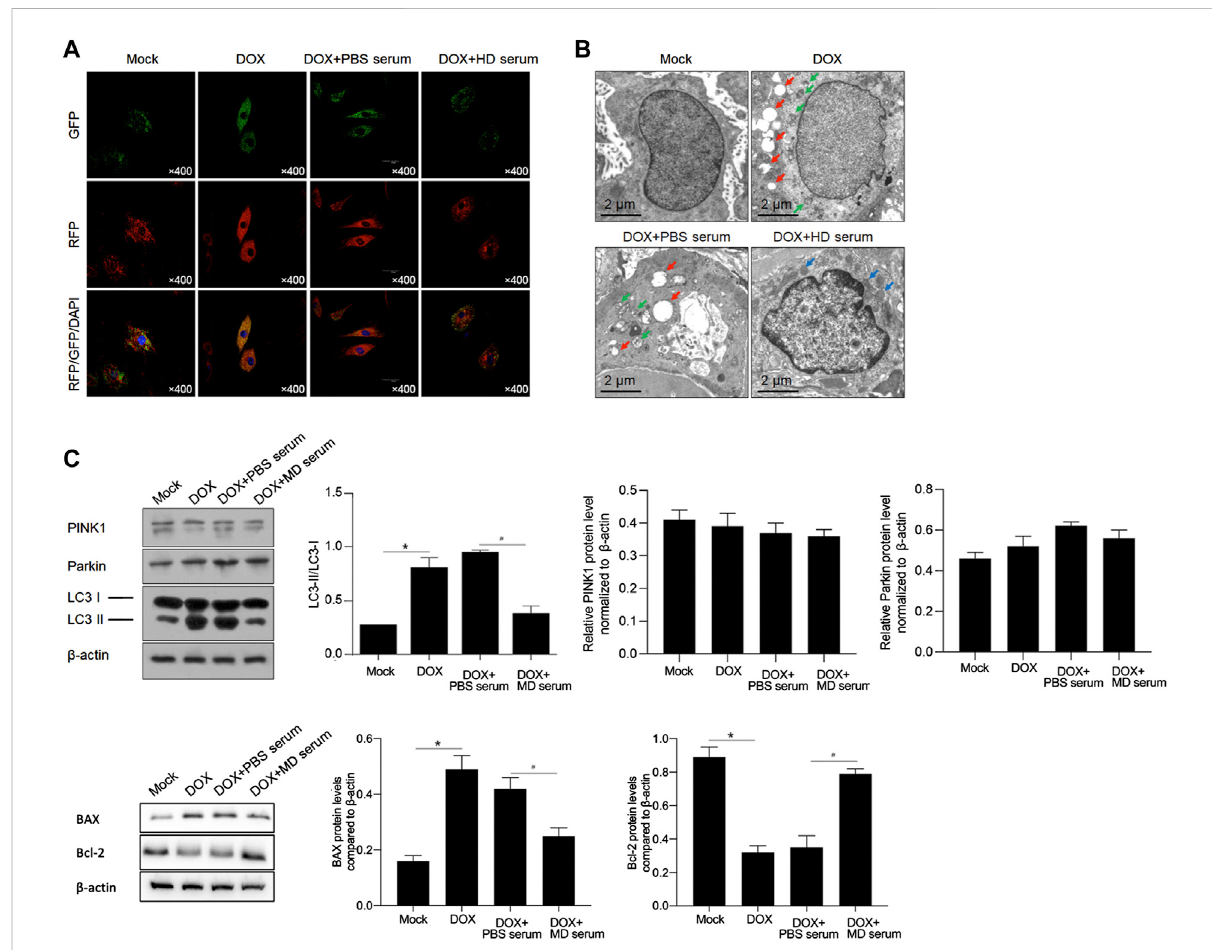
FIGURE 8 YXX keli inhibited autophagy/mitophagy in H9c2 cells. (A) . Formation of autophagosomes was measured by introducing GFP-RFP-LC3. (B) . Autophagic and mitophagic vacuoles were observed by performing electron microscopy (EM). (C) . Western blot was performed to detect PINK1, Parkin and cleavage of LC3 I and II. * p < 0.05, mock group; # p < 0.05, DOX + PBS-medicated serum. (D) . Western blot was further performed to detect Bax and Bcl-2 protein. * p < 0.05, mock group; # p < 0.05, DOX + PBS-medicated